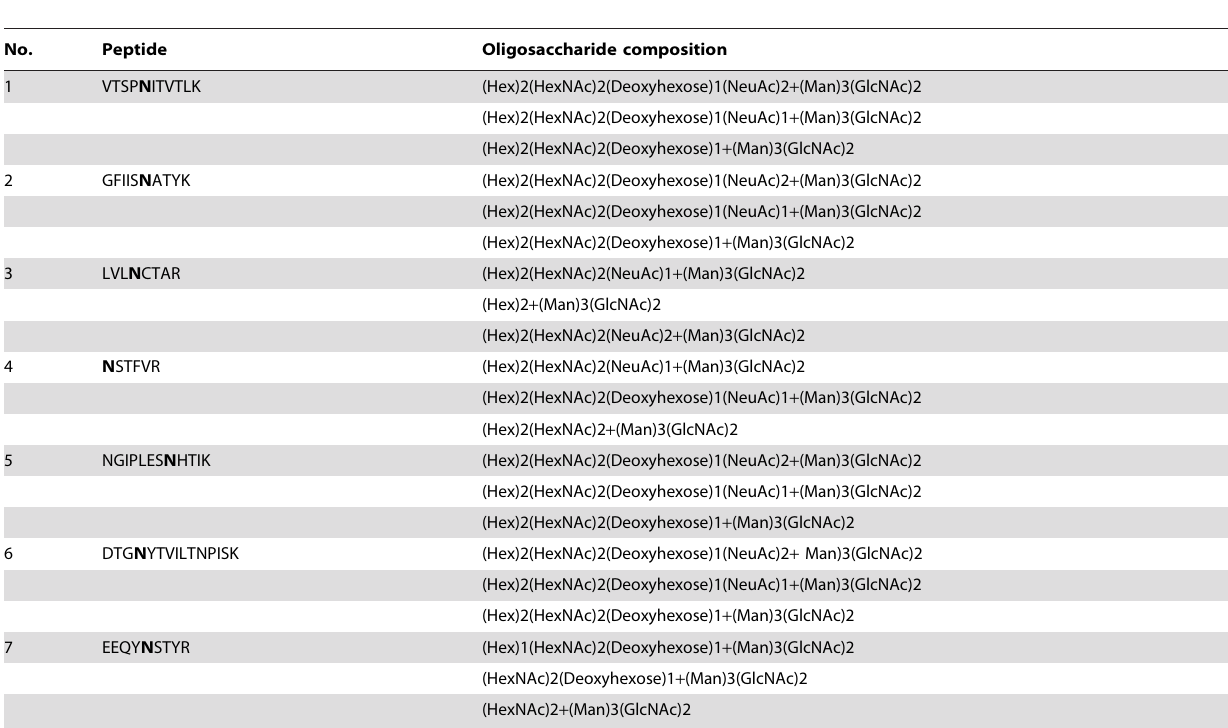
Table 2. All seven N -glycosylated tryptic peptides and the major oligosaccharide compositions at each site.